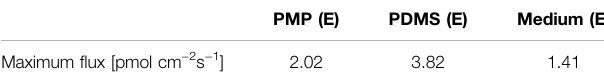
TABLE 3 | Maximum fl ux of oxygen in PMP, PDMS, and TCPS